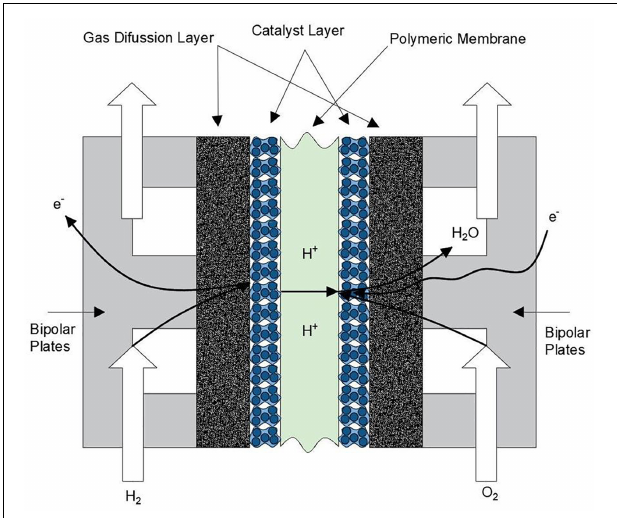
FIGURE 1 | Internal configuration of the constitutive parts of a single